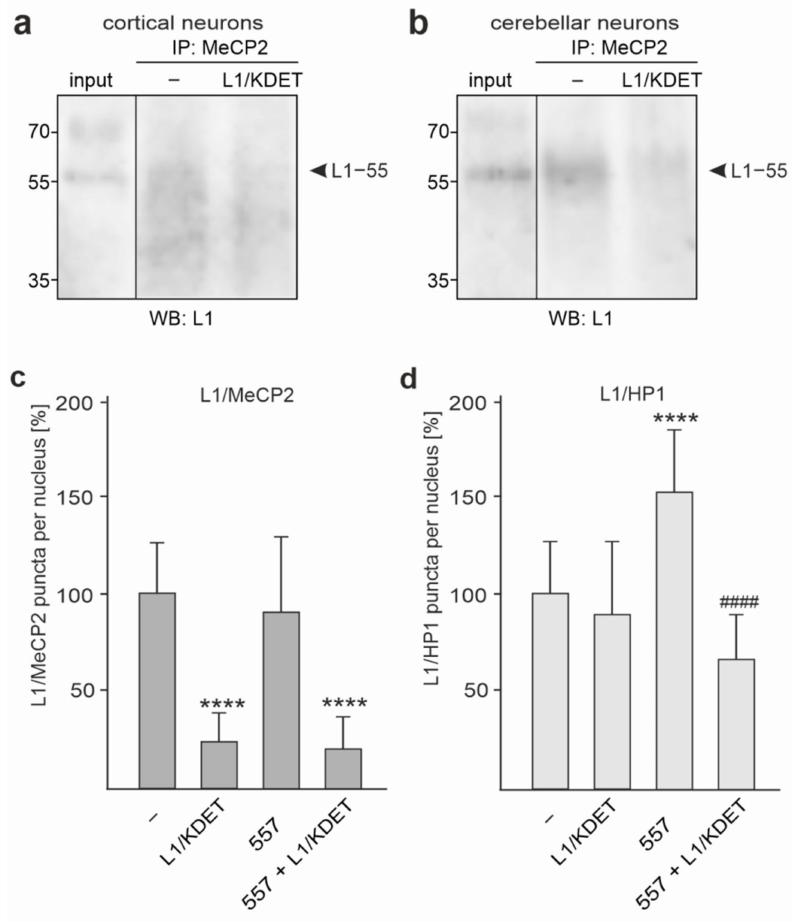
Figure 7. The MeCP2 and L1 interaction is disturbed by the tat-L1/KDET peptide. ( a , b ) Cultured cortical ( a ) and cerebellar ( b ) neurons were treated without ( − ) or with the cell-penetrating tat- L1/KDET peptide (L1/KDET). Nuclear extracts were isolated from the treated neurons and used for immunoprecipitation (IP) with MeCP2 antibody. The immunoprecipitates and the nuclear extracts (input) were subjected to Western blot analysis with L1 antibody C-2. Bands for L1 − 55 are indicated by black arrowheads. ( c , d ) Cortical neurons were treated without ( − ) or with cell-penetrating tat- L1/KDET peptide (L1/KDET), L1 antibody 557 alone (557), or L1 antibody 557 and tat-L1/KDET peptide (557 + L1/KDET). The transfected cells were then subjected to proximity ligation with an L1 and MeCP2 antibody ( c ). In parallel, proximity ligation with L1 and a mixture of HP1 α , - β , and - γ antibodies was performed ( d ). Mean values + SD from three experiments analyzing 200–500 cells per condition and experiment are shown for the average numbers of L1/MeCP2-positive (dark grey bars) ( c ) or L1/HP1-positive (light grey bars) ( d ) red puncta per cell relative to the control (values without peptide set to 100%) (**** p < 0.001 relative to untreated neurons, #### p < 0.001 relative to stimulated neurons; one-way ANOVA with Dunn’s multiple comparison